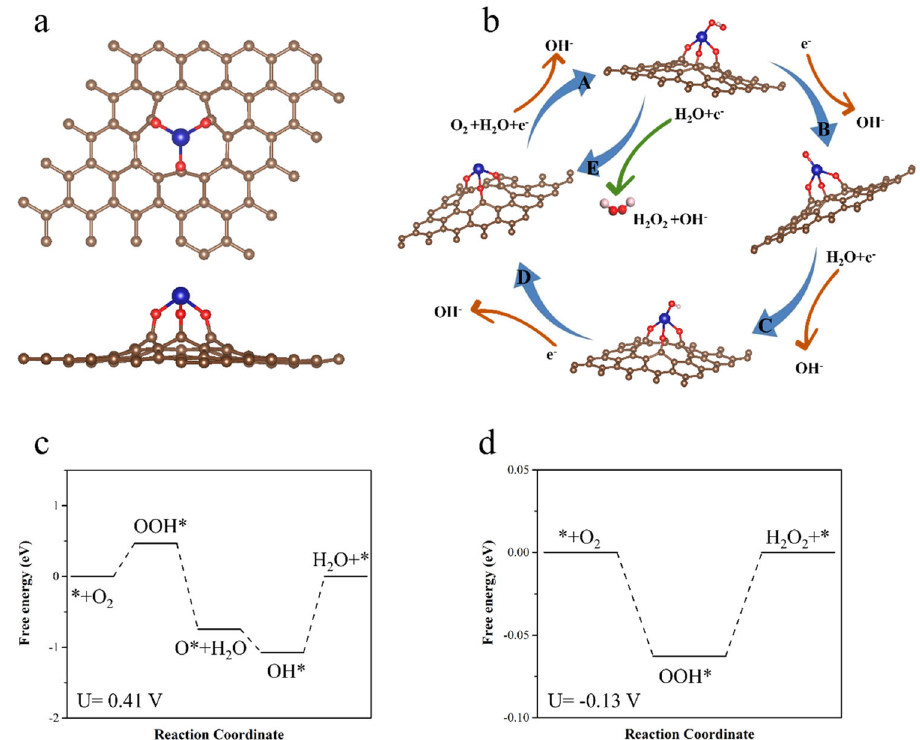
Fig. 5 Mechanistic investigation through DFT. a The model of Co-O 3 -C structure used for DFT calculation. The brown, red and blue balls represent C, O and Co atoms, respectively. b The reaction cycle scheme of the intermediates in four-electron and two-electron ORR process on the Co-O 3 catalytic center. c Free energy diagrams of four-electron under equilibrium state ( U = 0.41 V), and d free energy diagrams of two-electron ORR under equilibrium state ( U = − 0.13